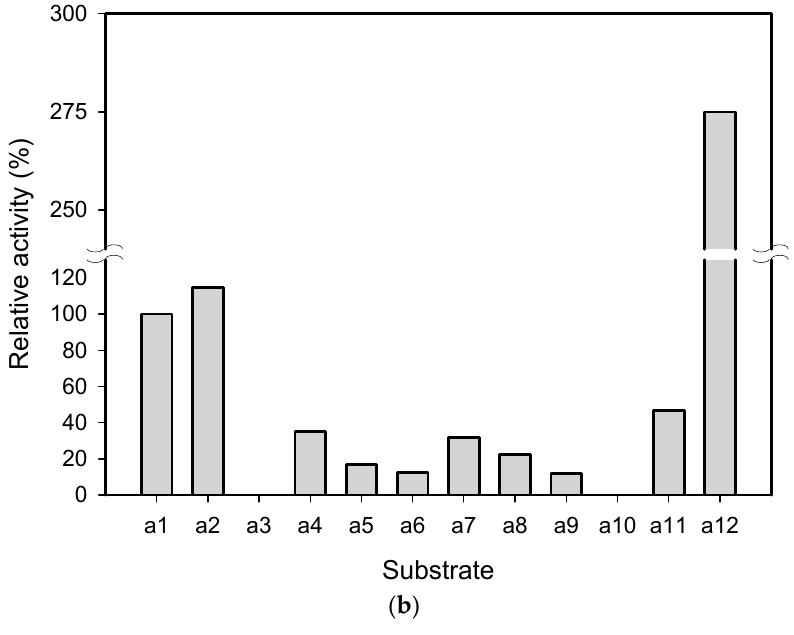
Figure 2. ( a ) Substrate spectrum; ( b ) Substrate specificity of AmDH. Oxidative deamination was carried out in 100 mM glycine buffer (pH 10.0) containing AmDH (0.15 mg/mL), 5 mM substrate, and 1 mM NAD + at 25 °C. One hundred percent (100%) corresponds to 44 mU/mg.